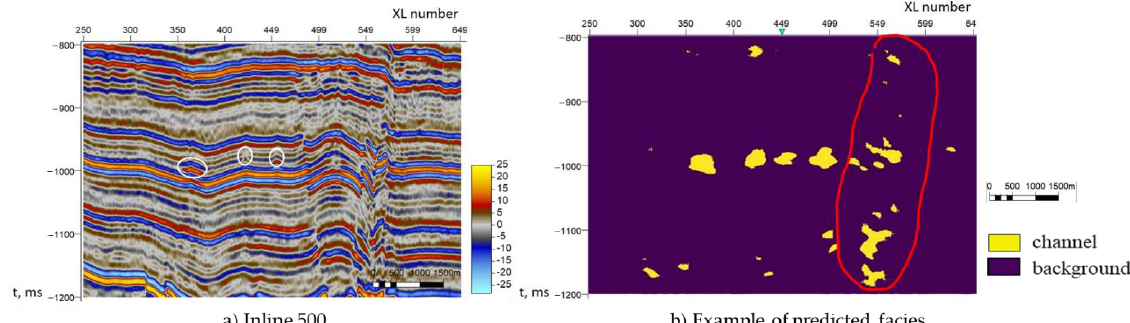
Figure 20. The IL500 with channel bodies circled ( a ) and an example of predicted facies ( b ). Notice misclassified channels along the faulted zone (circled in red), which is most likely caused by channel-like reflection contrast and geometry.